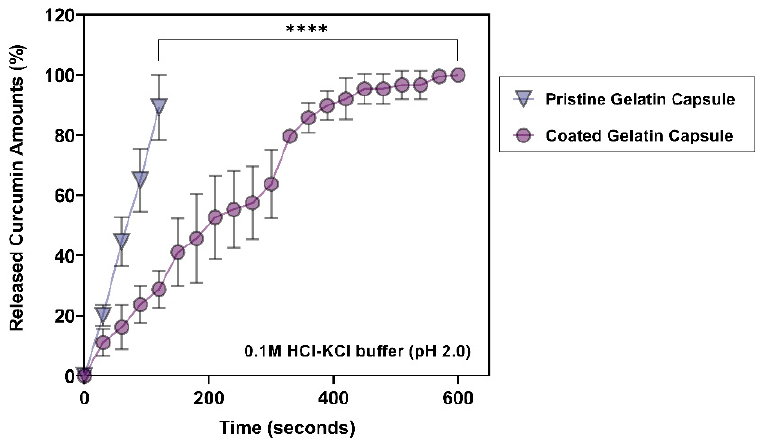
Figure 5. Accumulated curcumin release profiles from different gelatin capsules over time at pH 2.0. Significantly delayed release of curcumin over 10 minutes (600 s) was observed from EA doped enteric-coated gelatin capsules (n = 3 in each condition). ****: p < 0.0001.